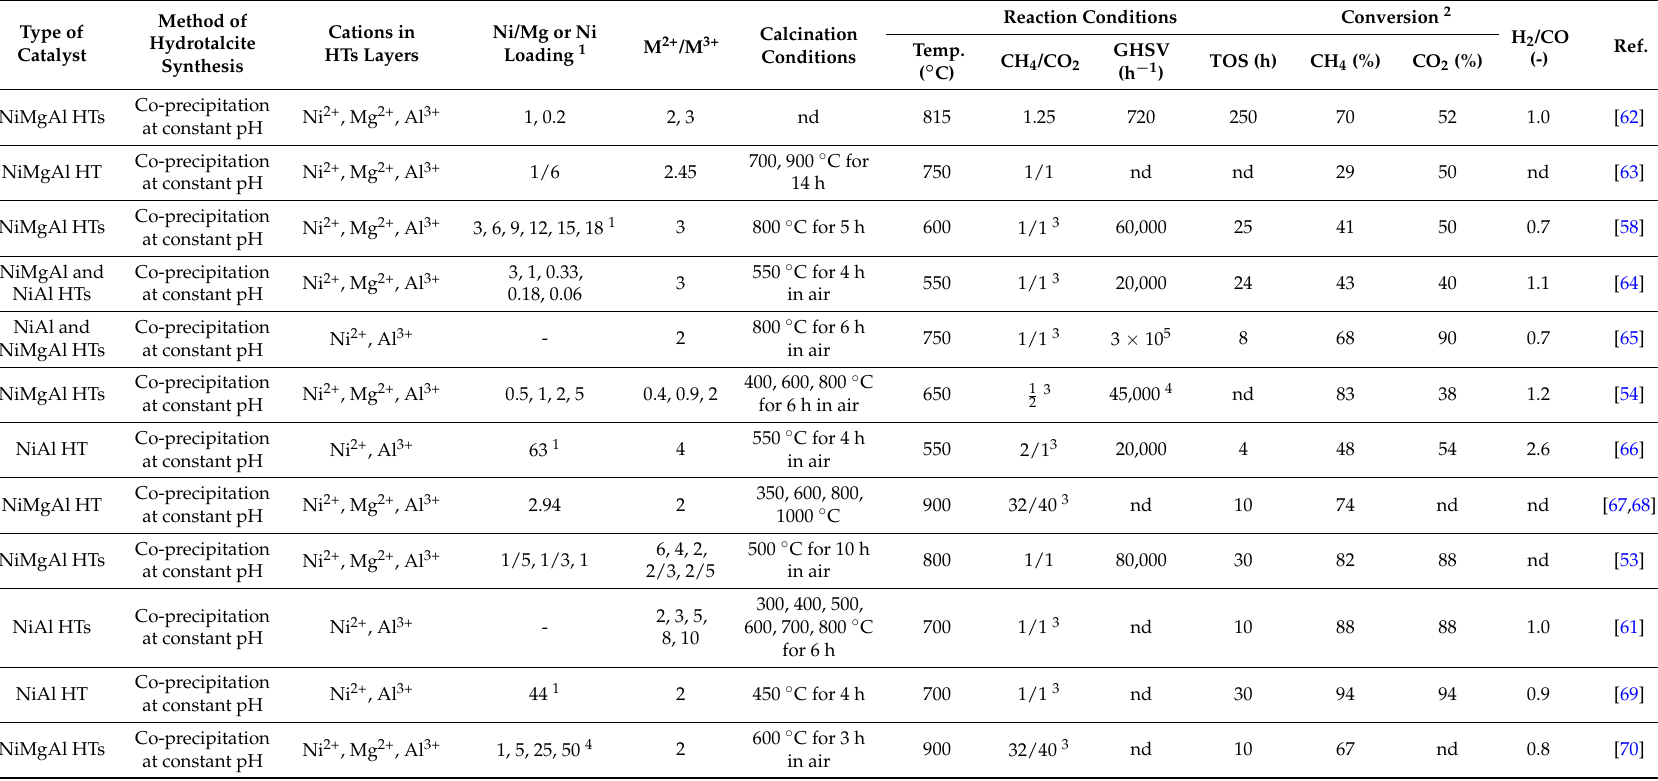
Table 1. Different Ni/Mg/Al and Ni/Al hydrotalcite-derived catalytic materials tested in DRM and reported in the existing